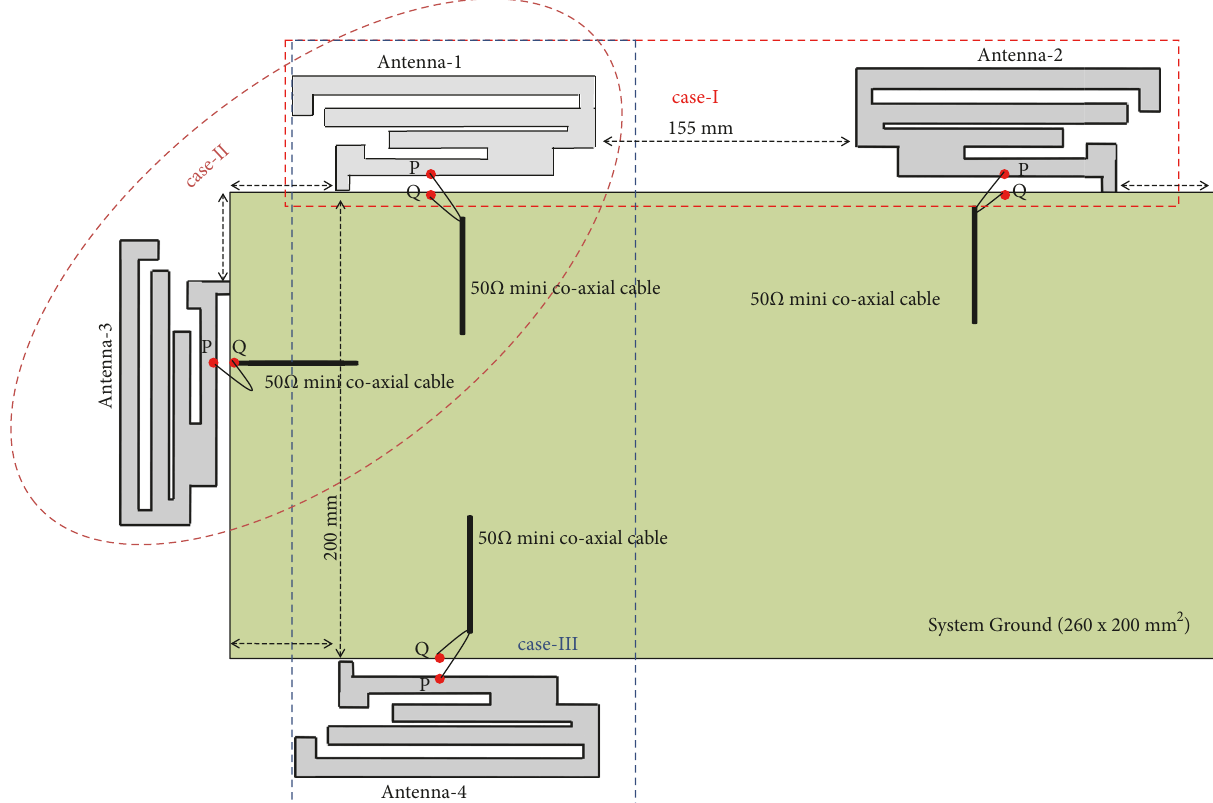
Figure 7: Possible Antenna Array cases for MIMO Applications mounted on the system ground.